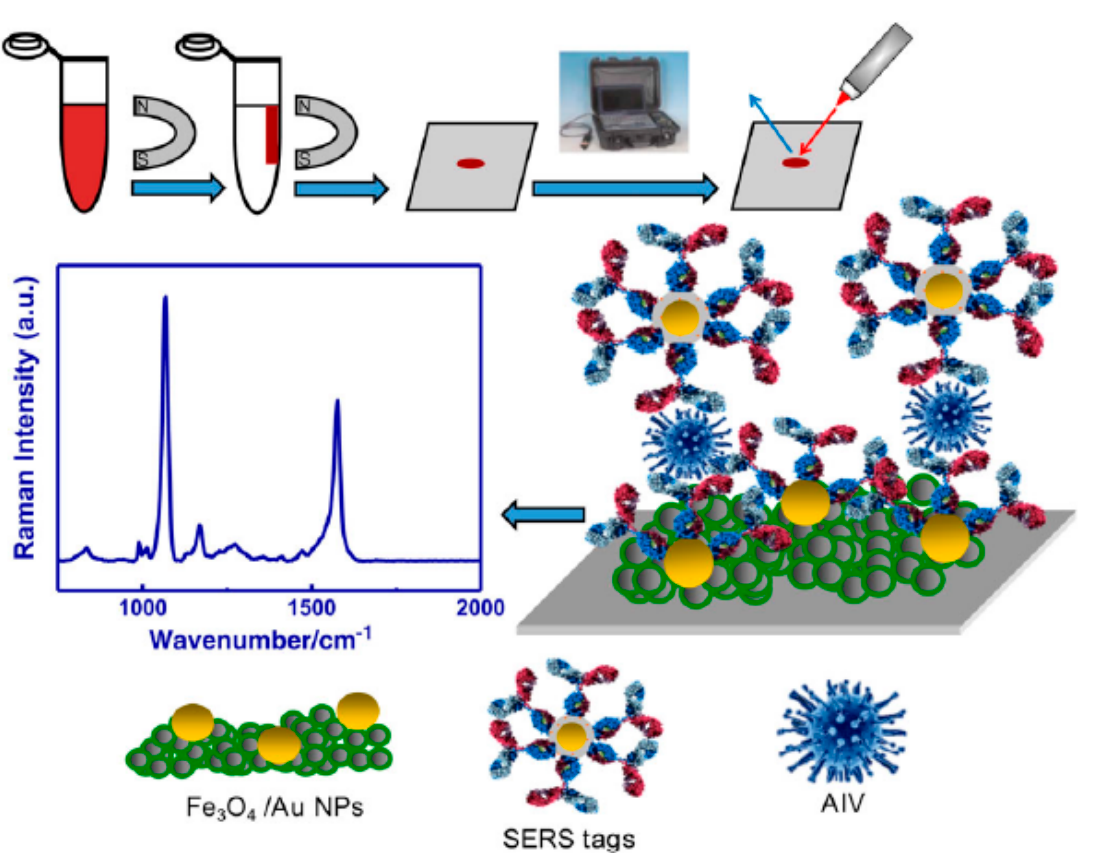
Figure 12. Illustration of an avian virus detection magnetic immunoassay based on surface-enhanced Raman scattering (SERS). Reproduced with permission from ref. [150]. Copyright 2017